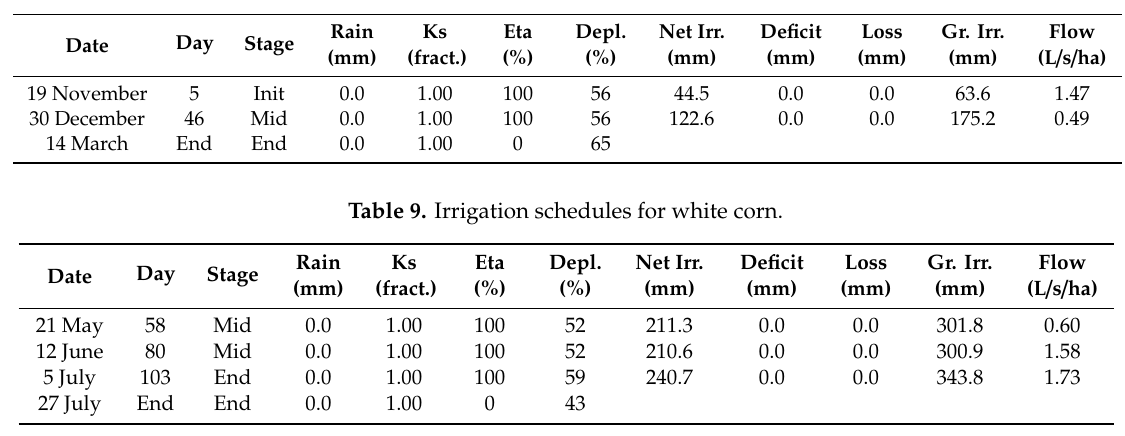
Figure 3. Irrigation schedules for barley .